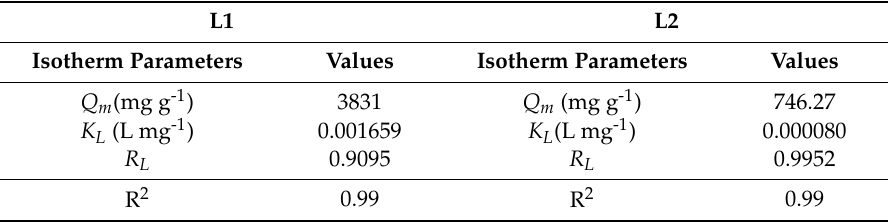
Table 1. Langmuir Isotherm data for the two types of substrates.